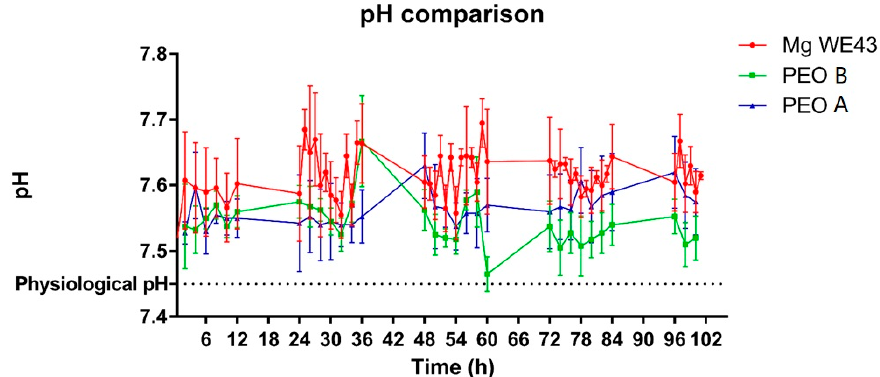
Figure 3. Measurement of the pH within the different cells linked to the degradation rate; time-dependent pH values for Mg WE43, PEO-B and PEO-A samples are shown in the graph. Values are displayed as means ± SD.